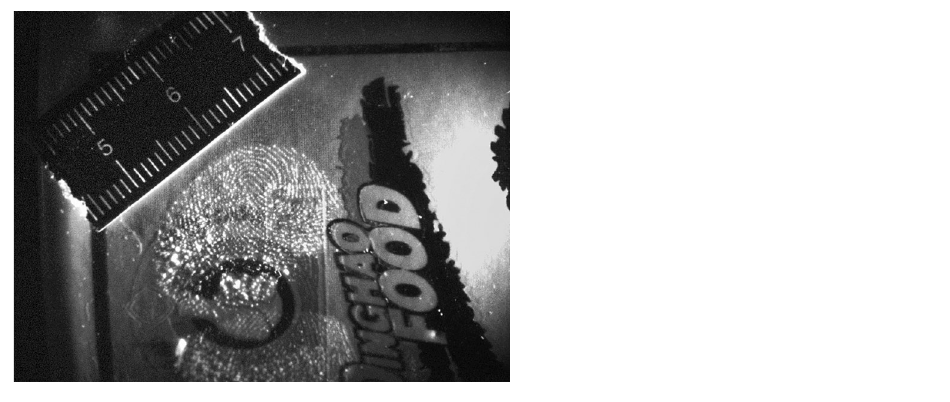
Figure 11. The resultant image from the case of Fig.